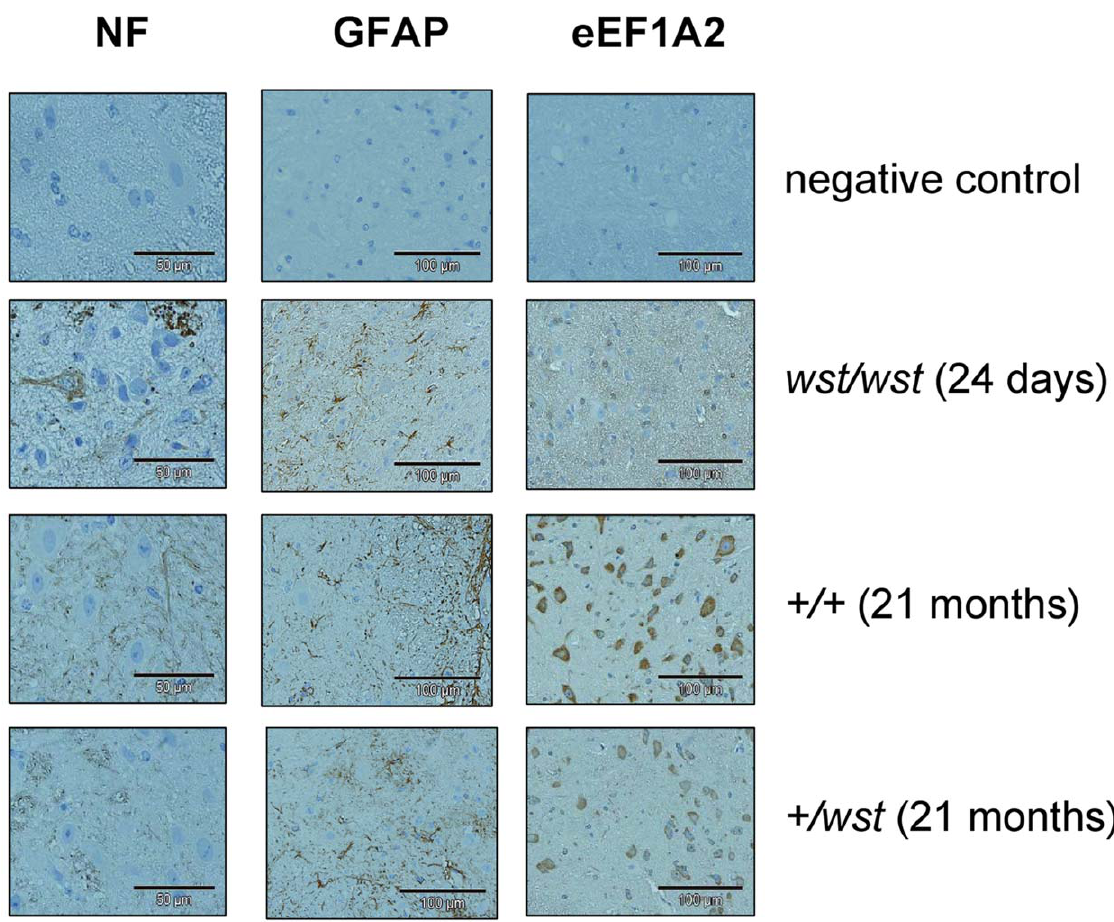
Figure 4. Immunohistochemistry in aged spinal cord sections. Expression of phosphorylated neurofilaments, GFAP, and eEF1A2 in cervical spinal cord sections from 21 month old mice. The top panel in each case shows a section with primary antibody omitted from the protocol, the second panel from the top shows sections from a 24 day old wasted homozygote as a control, and the bottom two panels show sections from an aged matched wild-type and heterozygous male. The NF staining clearly shows perikaryal accumulation of NF staining in the wasted mouse section but not in the aged + /wst mouse. The GFAP staining shows a characteristic pattern of reactive astrocytes throughout the grey matter of the spinal cord, even in the aged wild-type mouse. The eEF1A2 shows no staining at all in the section from the wst/wst mouse as expected, and fainter but easily detectable, albeit reduced, staining in the aged + /wst sample.